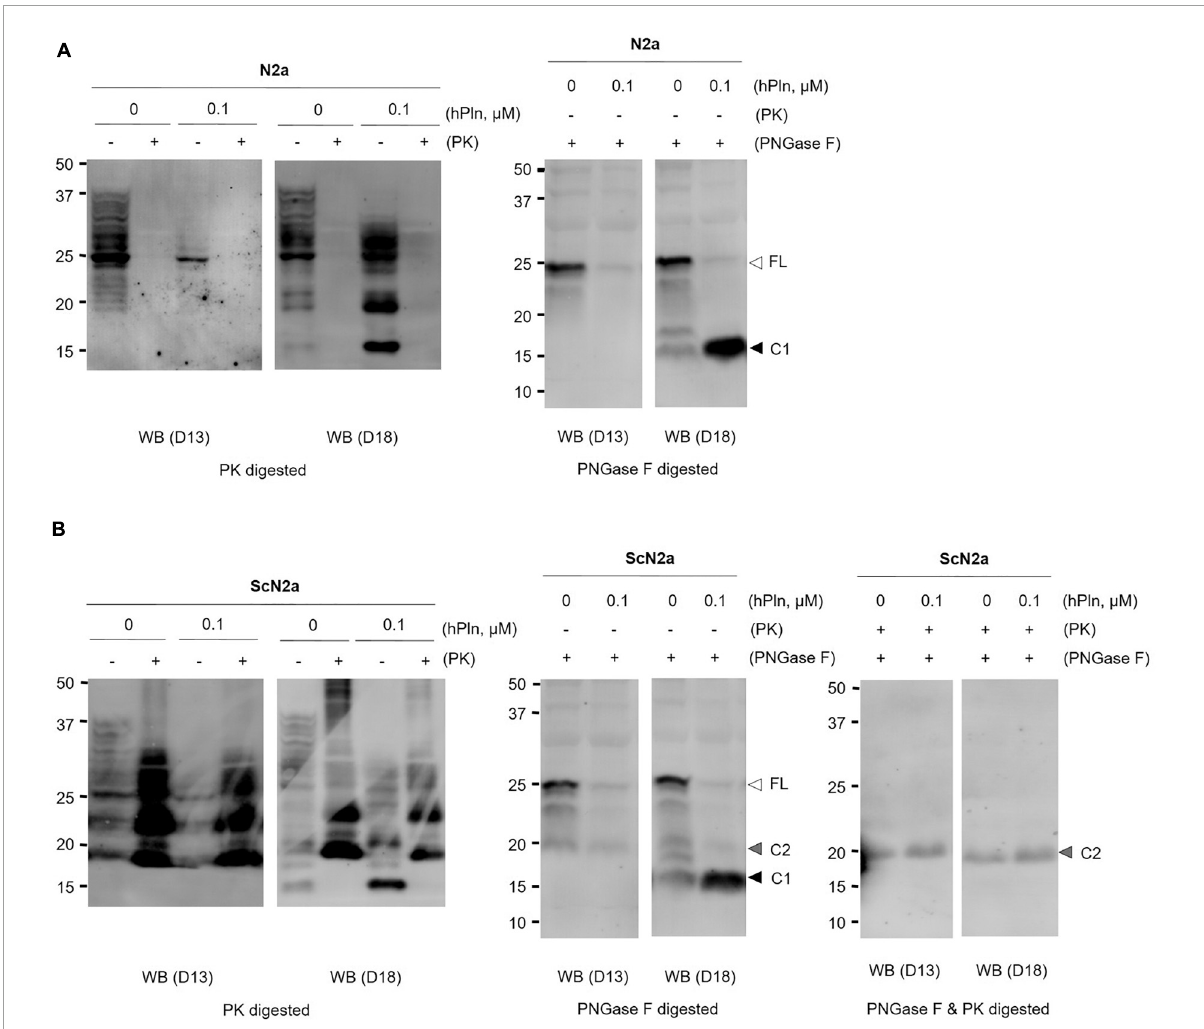
FIGURE2 Plasmin cleaves PrP C in cultured cells. (A) N2a cells were grown with supplemented hPln and analyzed the level of C1. The increased signals in the D18 blot were sensitive to PK digestion. PNGase F treatment revealed the unglycosylated C1 fragment probed with D18. (B) Persistently scrapie-infected ScN2a cells were grown with supplemented hPln and analyzed the level of C1. The level of C1 was increased by hPln. The level of C2 was not affected by hPln. white arrow, full-length (FL) PrP C ; black arrow, C1 fragment; gray arrow, C2